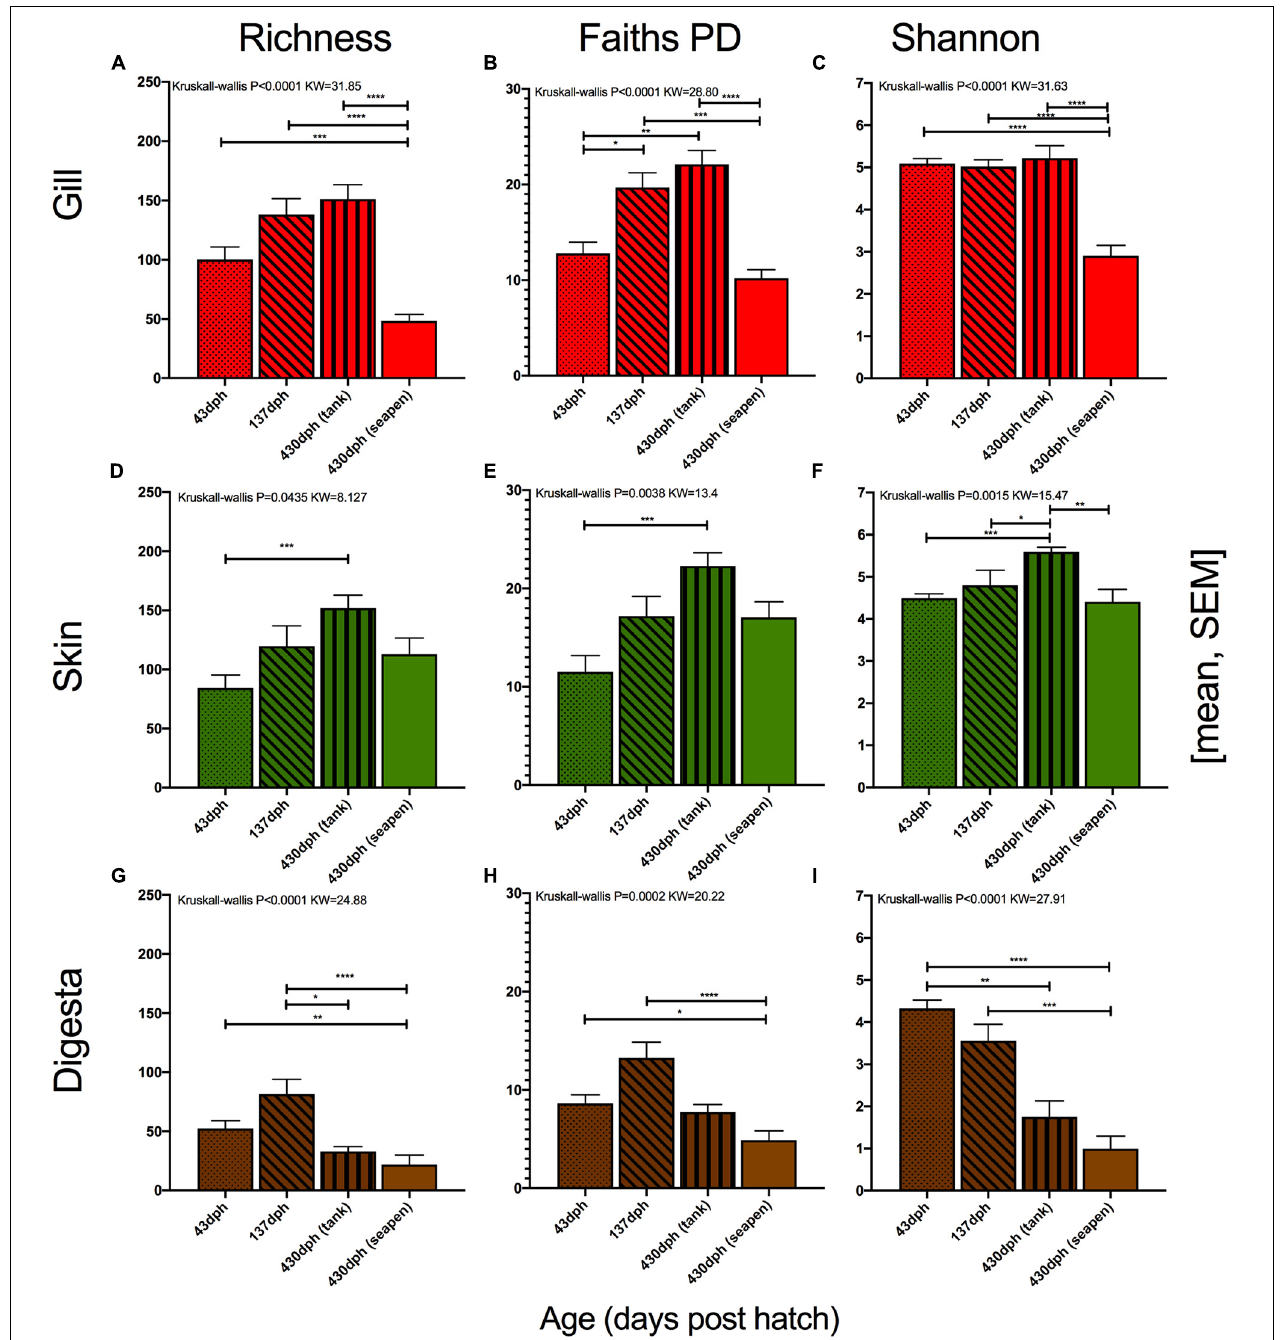
FIGURE 2 | Alpha diversity measures: richness, Faith’s Phylogenetic diversity, and Shannon diversity grouped per body site (red = gill, green = skin, and brown = digesta). Each body site assessed for diversity differences across age (Kruskal–Wallis, Benjamini-Hochberg FDR 0.05). Gill microbial diversity: (A) richness, (B) Faiths PD, and (C) Shannon; Skin microbial diversity: (D) richness, (E) Faiths PD, and (F) Shannon; and Digesta microbial diversity: (G) richness, (H) Faiths PD, and (I) Shannon. (* P < 0.05, ** P < 0.01, *** P < 0.001, and **** P < 0.0001).